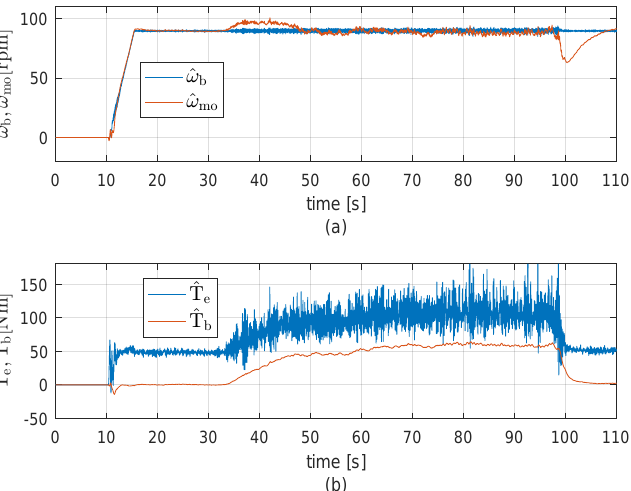
Figure 8. Evaluation of BSTO under drilling condition, considering low bandwidth observer tuning: ( a ) ˆ ω mo referred to bit side; ( b ) ˆ T e referred to bit side.